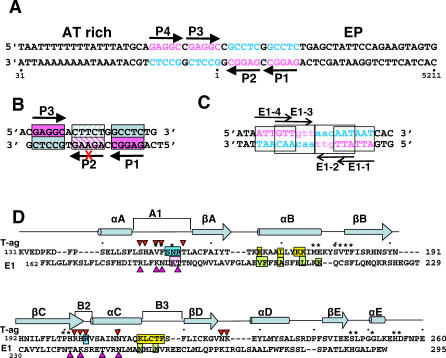
DNA and T-ag Sequences(A) The SV40 64-bp core-origin sequence. The pentanucleotides P1 through P4 are indicated above the sequence. Each GAGGC sequence is colored magenta, and its complement is cyan. The arrows indicate the 5′ → 3′ direction of the pentanucleotide sequence GAGGC. The AT-rich and early palindrome regions of the SV40 core origin are labeled.(B) The DNA duplex used in crystallization of the T-ag obd–DNA complex. This 21-mer contains the palindromic binding sites P1 and P3 and a mutated pentamer P2 site. The GAGGC sequences and their complements are indicated by magenta and cyan boxes, respectively. The altered P2 pentamer is indicated by hash-marks in magenta and cyan. As above, the arrows indicate the 5′ → 3′ direction of the pentanucleotide sequences, and the red X indicates that the P2 sequence is altered.(C) The BPV origin shows the E1 binding sites termed E1–1 through E1–4. The E1 binding sites are imperfect 5′-ATTGTT-3′ hexameric sequences. Boxes outline each binding site, and the binding sites are labeled. The arrows indicate the 5′ → 3′ direction of the binding site. The direct repeats (sites E1–1 and E1–2 or sites E1–3 and E1–4) overlap by 3 bp. The ATTGTT sequence (magenta) and its complement (cyan) are indicated. Lowercase letters are used for the portion of binding sites that do not overlap.(D) Structure-based sequence alignment of SV40 T-ag obd with BPV E1 obd. The secondary structure elements of the T-ag obd are shown above its amino acid sequence. Every tenth residue is indicated with a dot. T-ag obd residues that make base-specific contacts in the DNA co-structure are indicated by cyan boxes. T-ag obd residues that make phosphate interactions are indicated by red triangles above the amino acid sequence. There are two types of T-ag obd–obd interactions: the “head-to-head” type seen in the disulfide-linked dimer (possibly important in double-hexamer formation), and the “side-to-side” type (important in single-hexamer formation) seen in the spiral hexamer. T-ag obd residues that form the protein–protein interface in the disulfide-linked dimer structure are indicated by yellow boxes. T-ag obd residues that comprise the protein–protein interface in the spiral hexamer are indicated by an asterisk (*). Residues for BPV E1 obd that make base-specific contacts or phosphate contacts or participate in its dimer interface are indicated by pink boxes, magenta triangles below the E1 sequence, and green boxes, respectively. The information for E1 was obtained from the crystal structures of E1-obd with and without DNA.